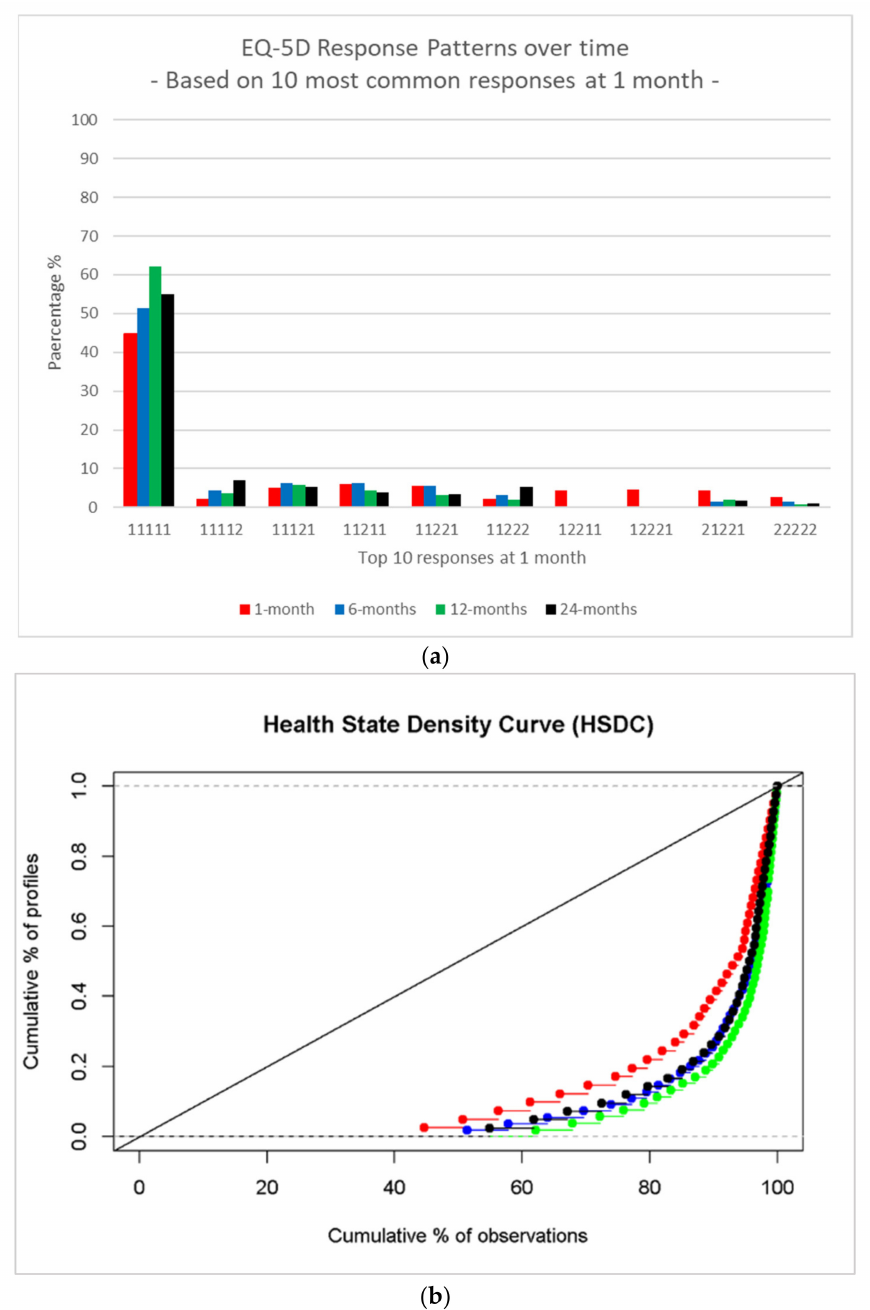
Figure 2. ( a ) EQ-5D health state response patterns over time based on the 10 most common responses in 1 month. 1 = no problems, 2 = problems. The pattern order for health states = (mobility self- care activity pain, anxiety, and depression). ( b ) Health state density curve (HSDC) across time: red = 1 month, blue = 6 months, green = 12 months, black = 24